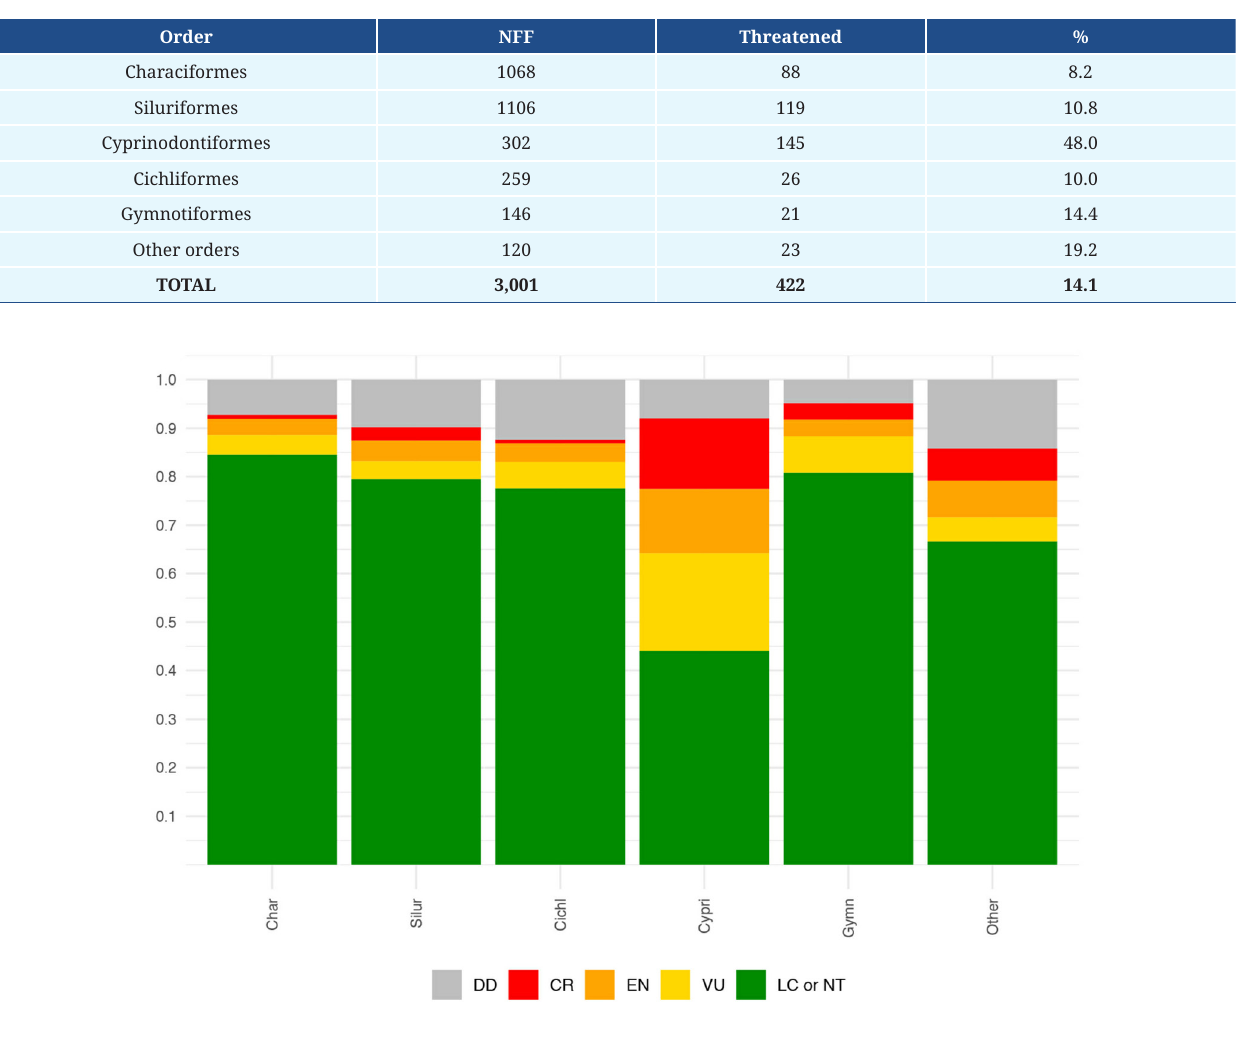
FIGURE 2 | Extinction risks in 3,001 Neotropical freshwater fishes (NFF). On average, 14% (422 of 3,001) NFF species are classified by the IUCN Red List (RL) as Vulnerable (VU), Endangered (EN) or Critically Endangered (CR). Extinction risks are relatively similar among the orders Characiformes (8.2%), Siluriformes (10.8%), Cichliformes (10.0%), and Gymnotiformes (14.9%). An exception is the clade Cyprinodontiformes, where about 48% of species are classified as either VU, EN, or CR. LC or NT: Least Concern or Near Threatened; DD: Data Deficient.